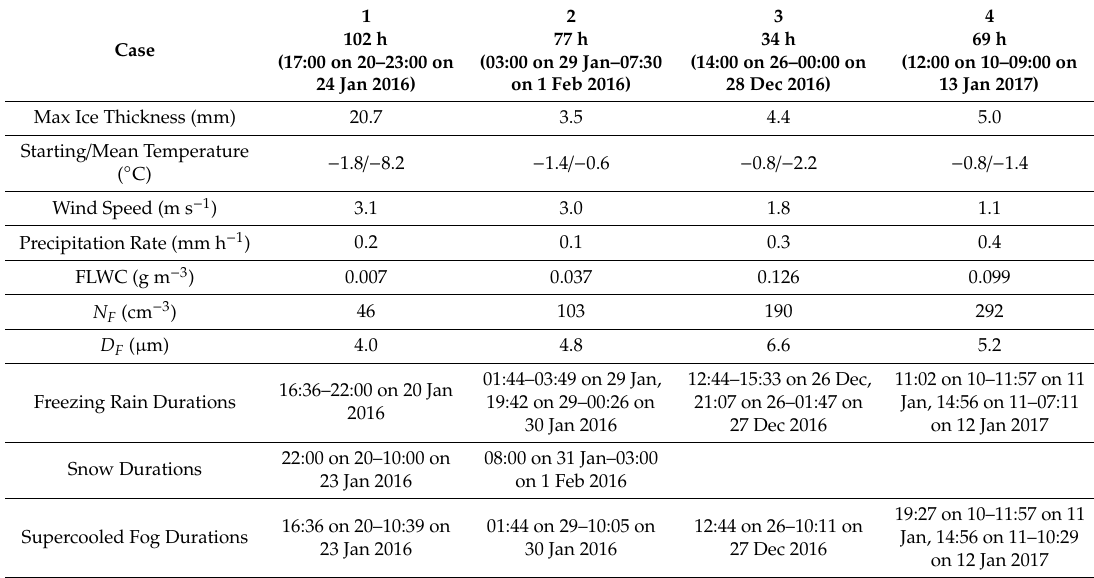
Table 2. Max ice thickness, air temperature, mean wind speed, mean precipitation rate, mean fog liquid water content (FLWC), mean fog droplet number concentration ( N F ), fog droplet mean diameter ( D F ), and freezing rain, snow, and supercooled fog durations in four icing